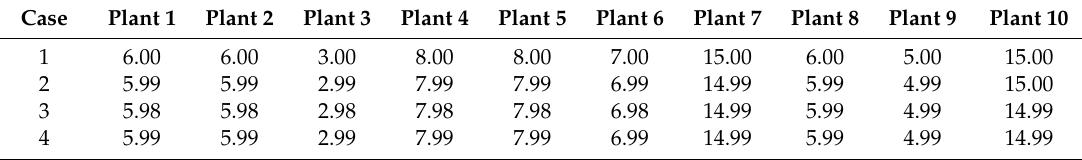
Table 7. Final storages (V end ) of the reservoir system in four cases.